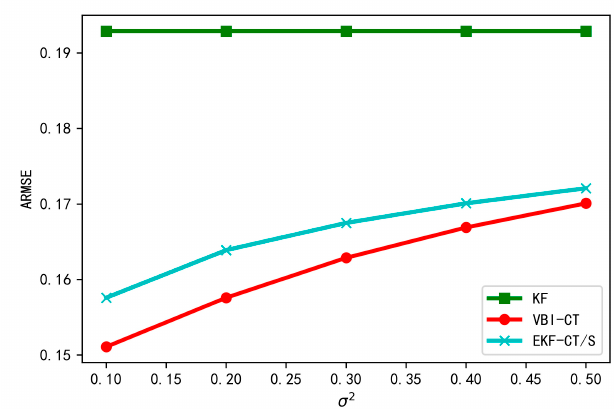
Figure 10. Tracking error under stationary localization noise.